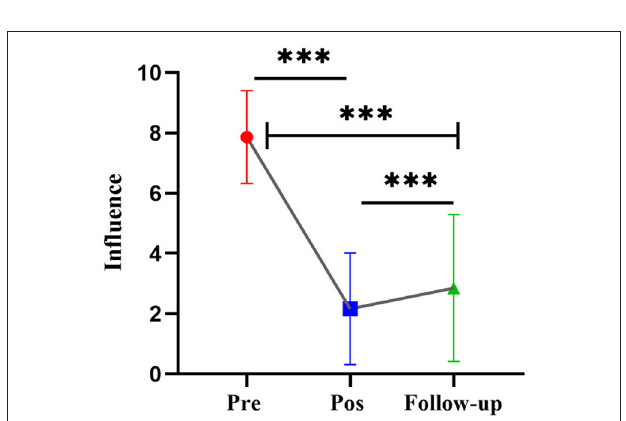
FIGURE 3 | The repeated measurement analysis of influence index. *** p <